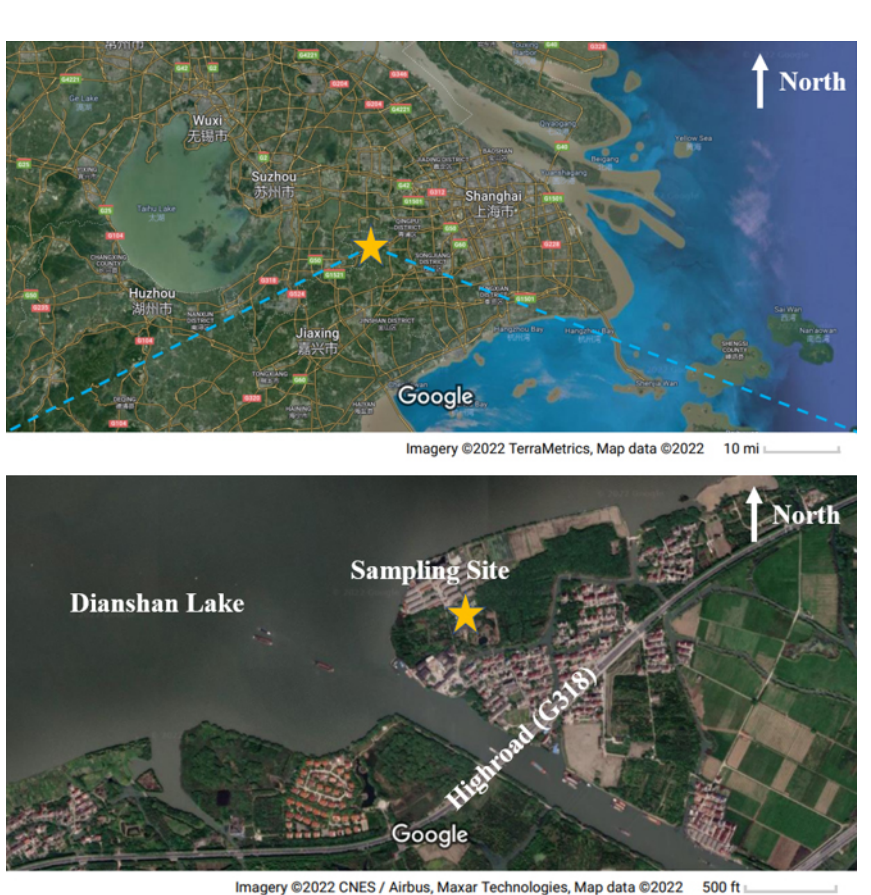
Figure 1. A topography map (from © Google Maps) of the region around the Dianshan Lake (DSL) Air Quality Monitoring Supersite (31.10 ◦ N, 120.98 ◦